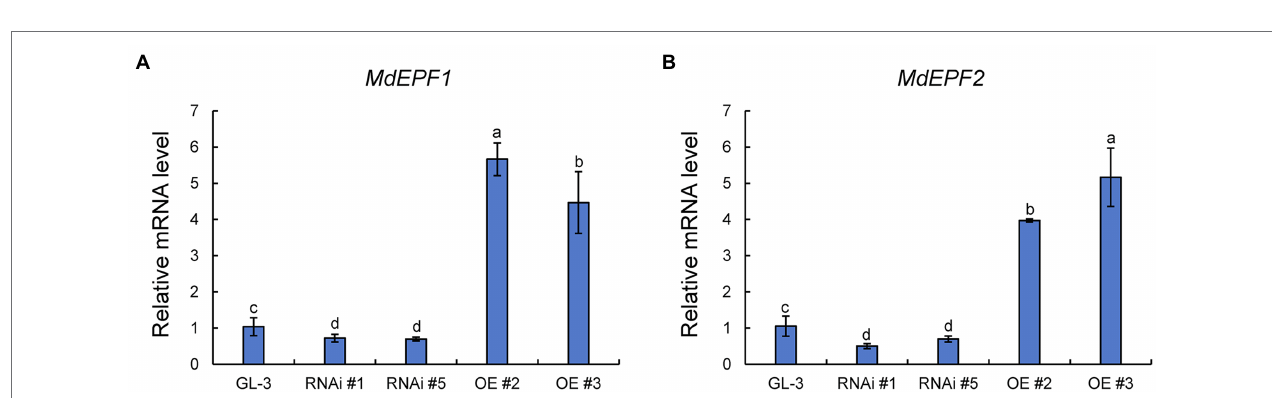
FIGURE 3 | Effect of MdHB-7 expression on stomatal density, leaf water loss, and relative water content. (A) Micrographs of abaxial leaf epidermis from GL-3 and MdHB-7 transgenic plants. Scale bars, 50 μ m. (B) Stomatal density of the leaf abaxial epidermis of GL-3 and MdHB-7 transgenic plants. (C) Relative water loss from detached leaves measured at the indicated time points. (D) Relative water content. Data are means ± SD ( n ≥ 50 for B , at least 50 stomatal densities were measured per genotype; n = 5 for C , D ). Different letters indicate significant differences among genotypes based on one-way ANOVA and Tukey’s multiple range test ( p < 0.05).